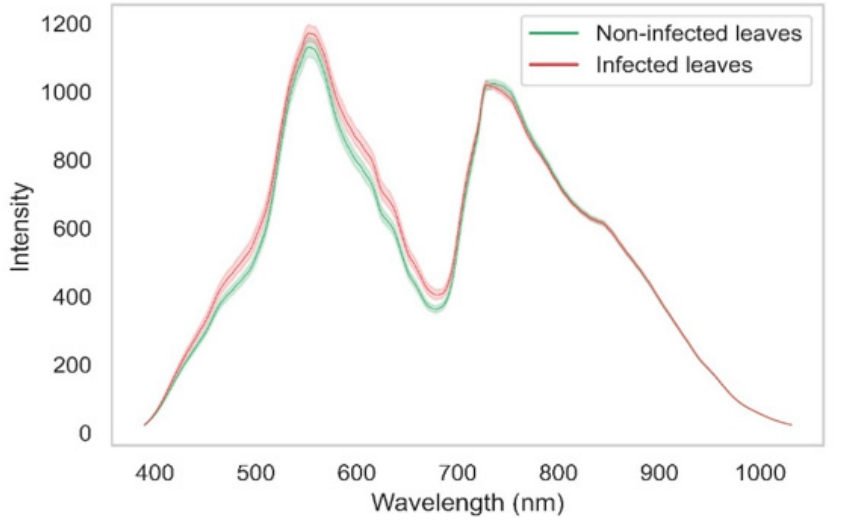
Figure 4. Raw spectra of non-infected and infected grapevine leaf discs from 9 DPI (days post inoculation) with downy mildew. The spectra shown summarise all the spectra of each group by their mean (line) and standard deviation (smoothed area).